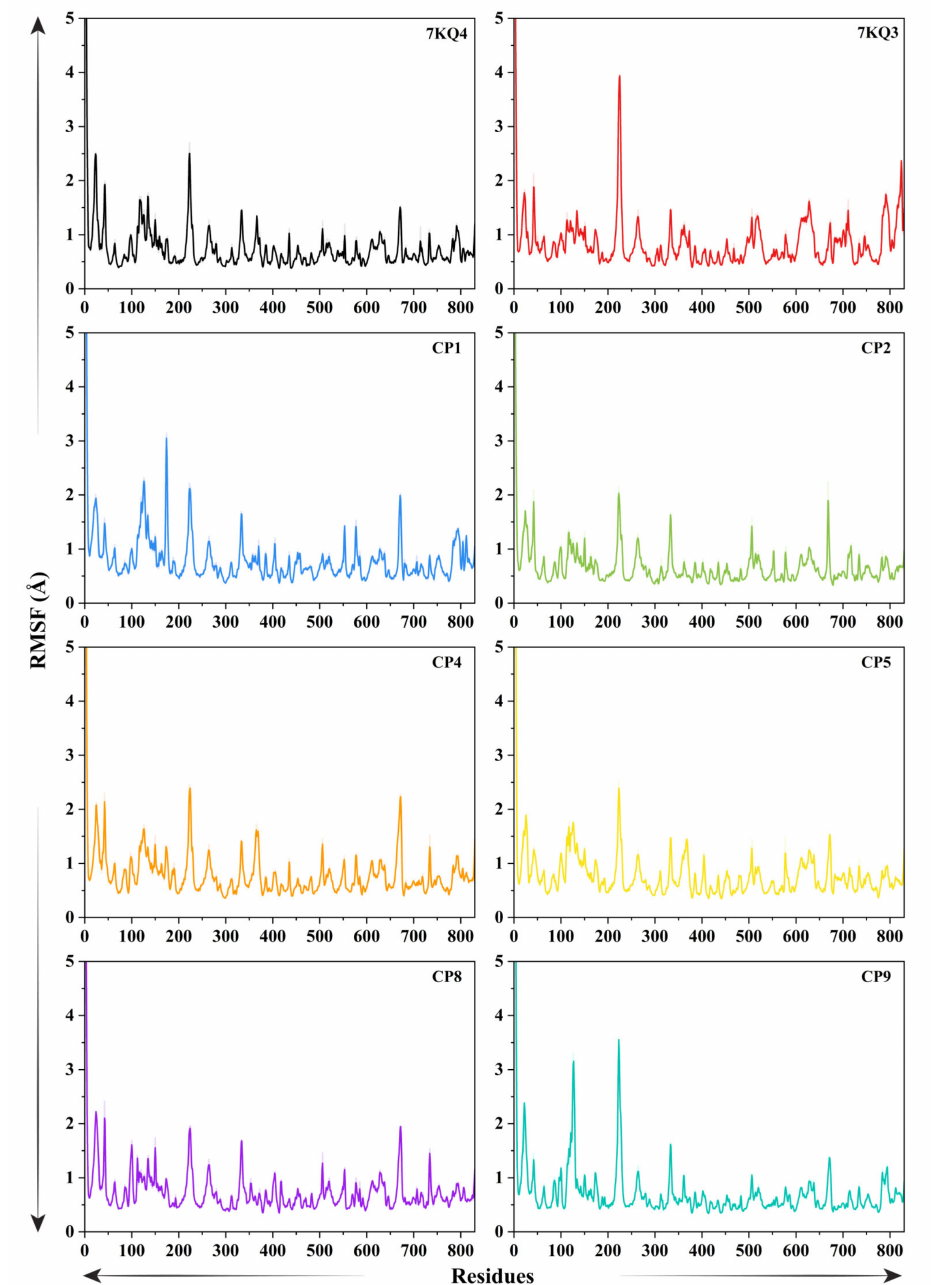
Figure 4. Graphical illustration of residual fluctuations of Isla via root mean square fluctuation (RMSF) in free state (7KQ4), reference complex (7KQ3), and selected ligands bound states. Each system is represented by a distinctive